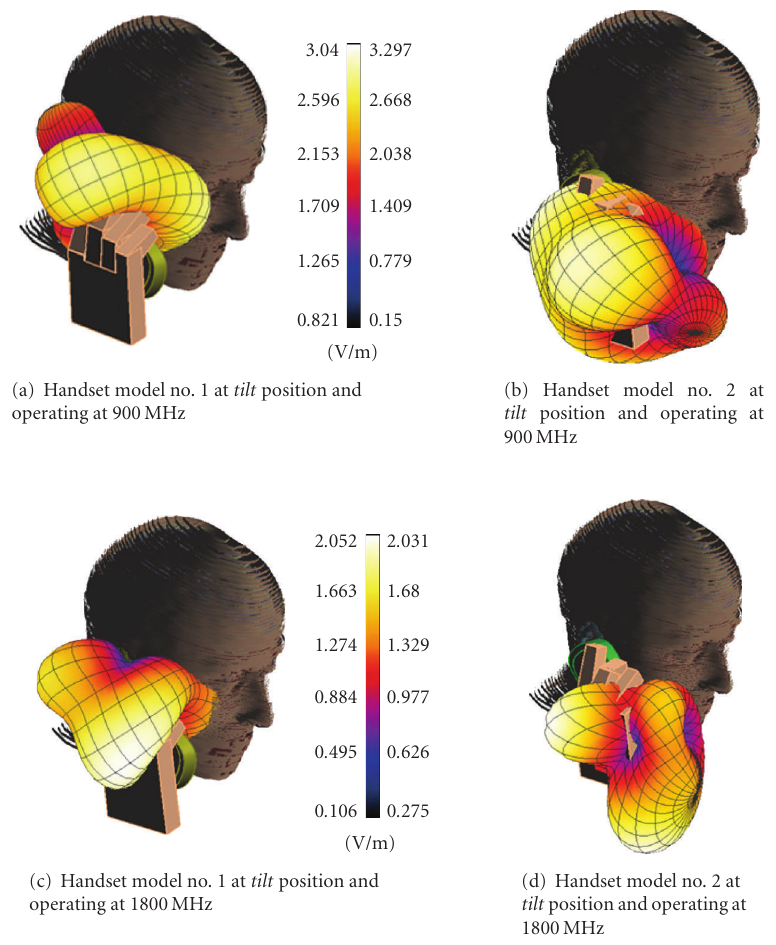
Figure 8: The three-dimensional radiation pattern in (V/m) of both handset models in hand close to HR-EFH at tilt position and operating at di ff erent frequencies.